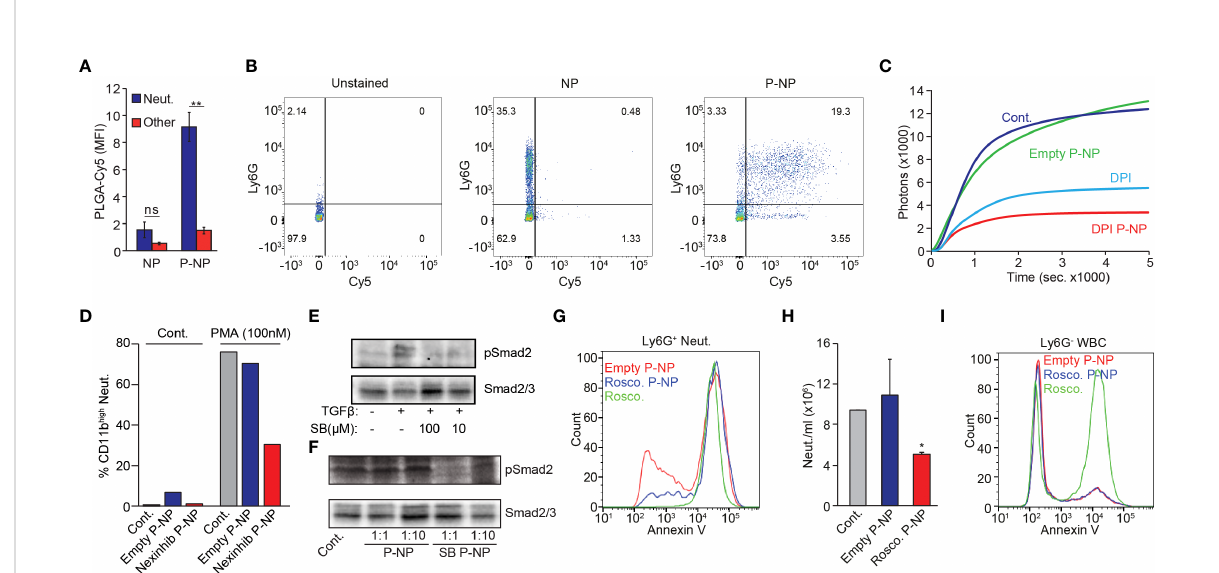
FIGURE 2 P-NP Mediated Modulation of Neutrophil Function In Vitro. (A) Representative quanti fi cation of uncoated or LQI-coated NP binding to neutrophils (blue) or other WBC (red). (B) FACS plots showing uncoated (middle) or LQI tetramer coated (right) Cy5-labelled PLGA NP binding to Ly6G + neutrophils in whole blood. Left panel shows unstained control. RBC were lysed prior to FACS analysis. Cells with high side scatter (SSC) represent neutrophils. (C) PMA (50 nM) induced ROS production in control neutrophils (Cont.), neutrophils treated with empty (Empty NP) or DPI-containing P-NP (DPI NP) or with free DPI (DPI, 10 µM). (D) FACS analysis of CD11b expression in neutrophils before (Cont.) or following PMA (100 nM) stimulation. Neutrophils were preincubated with vehicle, empty or Nexinhib-20 loaded LQI tetramer coated NP # . (E) Upper panel - western blot analysis showing Smad2 phosphorylation in neutrophils stimulated with TGF b (10 ng/µl, 30 min.) in the presence of SB431542 (100 m M or 10 m M). Control neutrophils (leftmost lane) were treated with vehicle. Lower panel - western blot analysis of Smad 2/3 serving as loading control for the samples in the upper panel. (F) Western blot analysis of Smad2 phosphorylation and Smad2/3 expression in neutrophils which were pre-incubated with 6 or 0.6 m g/ m l empty (1:10) NP, 6 or 0.6 m g/ m l (1:10) SB431542 NP before stimulating with TGF b (10 ng/ m l, 30 min.). Control cells were treated only with TGF b . Lower panel - western blot analysis of Smad 2/3 serving as loading control for the samples in the upper panel. (G) Ly6G + Neutrophils isolated from 4T1-tumor bearing mice were incubated with empty P-NP, roscovitine-loaded P-NP or free Roscovitine. Subsequently cells were analyzed for Annexin-V binding to quantify apoptotic cells. (H) Effect of empty or roscovitine- containing P-NP on neutrophil numbers 4 hrs following P-NP administration. (I) Non-neutrophil Ly6G - cells isolated from 4T1-tumor bearing mice were incubated with empty P-NP, roscovitine-loaded P-NP or free Roscovitine. Subsequently cells were analyzed for Annexin-V binding to quantify apoptotic cells. The experiments were repeated at least 3 times with similar results. Error bars represent ± SEM. * p<0.05, ** p<0.01. ns, not signi fi cant. # The experiment was done several times in different combination of experimental conditions which cannot be averaged and presented with error